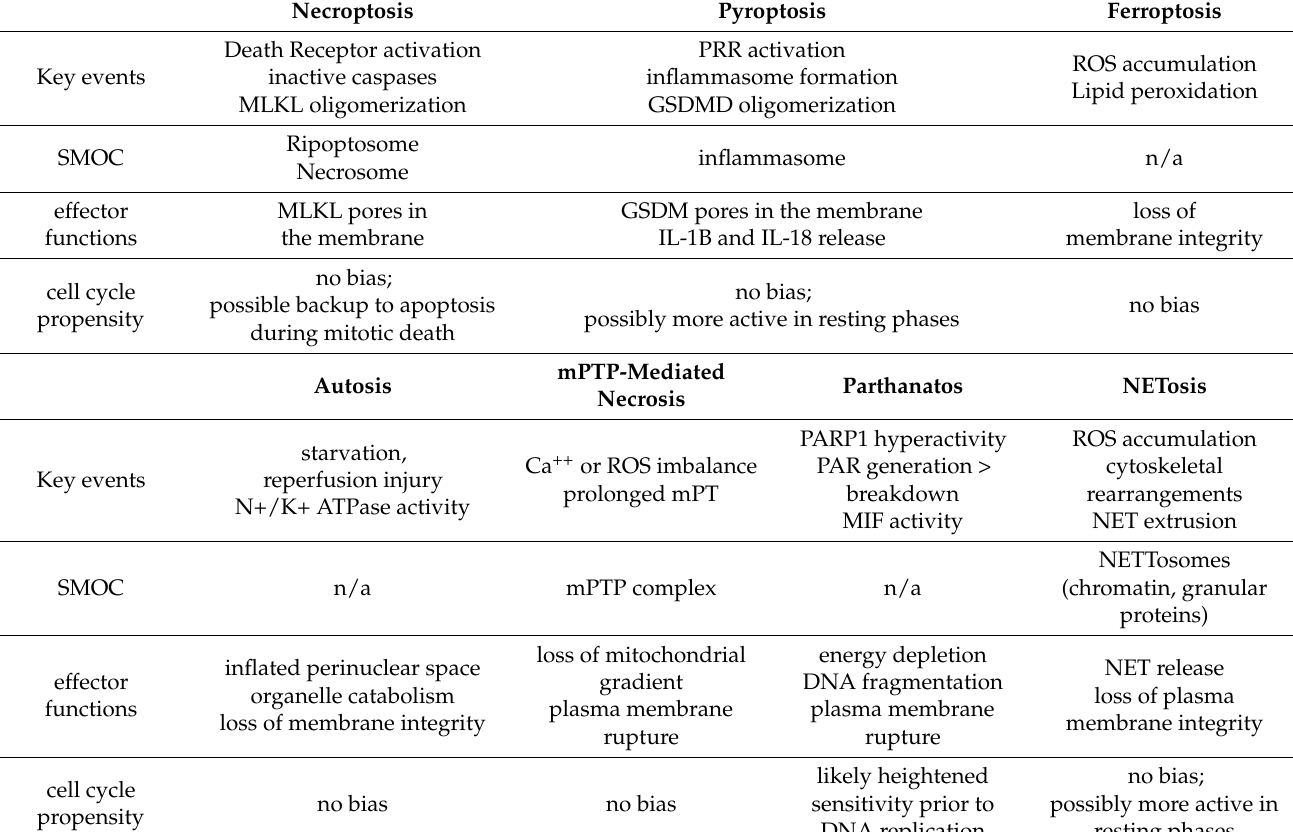
Table 1. Core components of Immunogenic Death